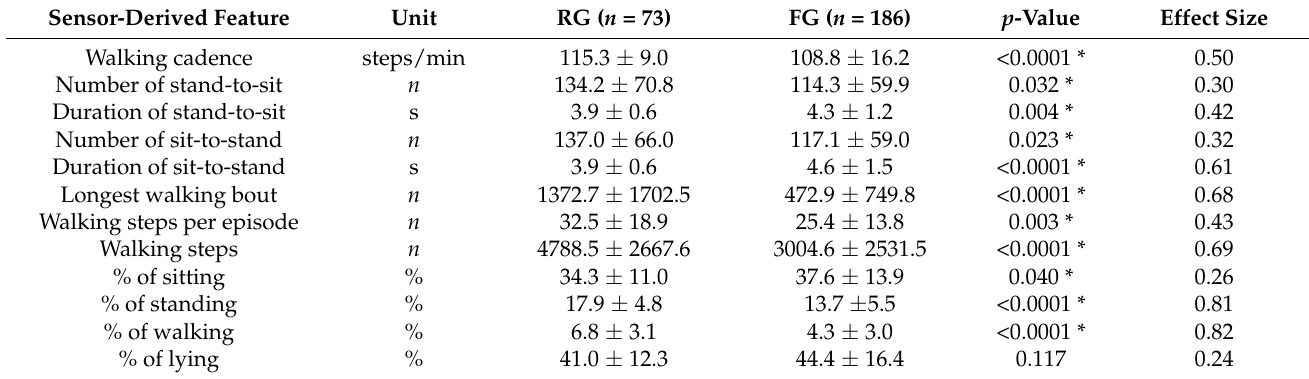
Table 3. Comparison of sensor-derived features between the robust group (FG) and pre-frail/frail group (FG). Sensor-Derived